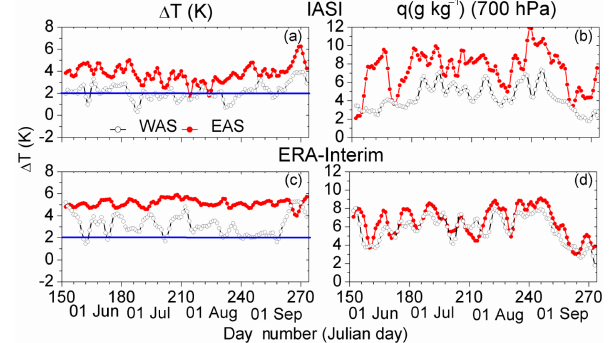
Figure 4. Percentage occurrence of (a) (cid:49)T and (b) q at 700hPa observed in the WAS and EAS during monsoon season of the years 2009–2013 for various ranges of (cid:49)T and q at 700hPa by IASI. Panels (c) and (d) are the same as panels (a) and (b) but obtained from ERA-Interim data.